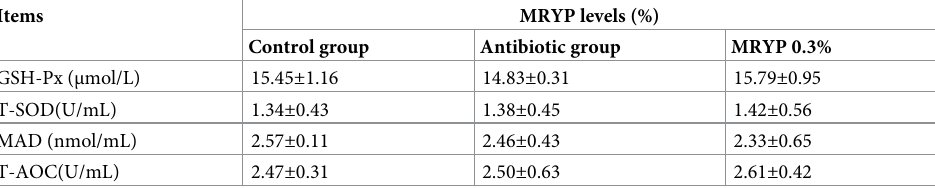
Table 10. Effect of MRYP on the serum antioxidant enzymes activity of lambs.